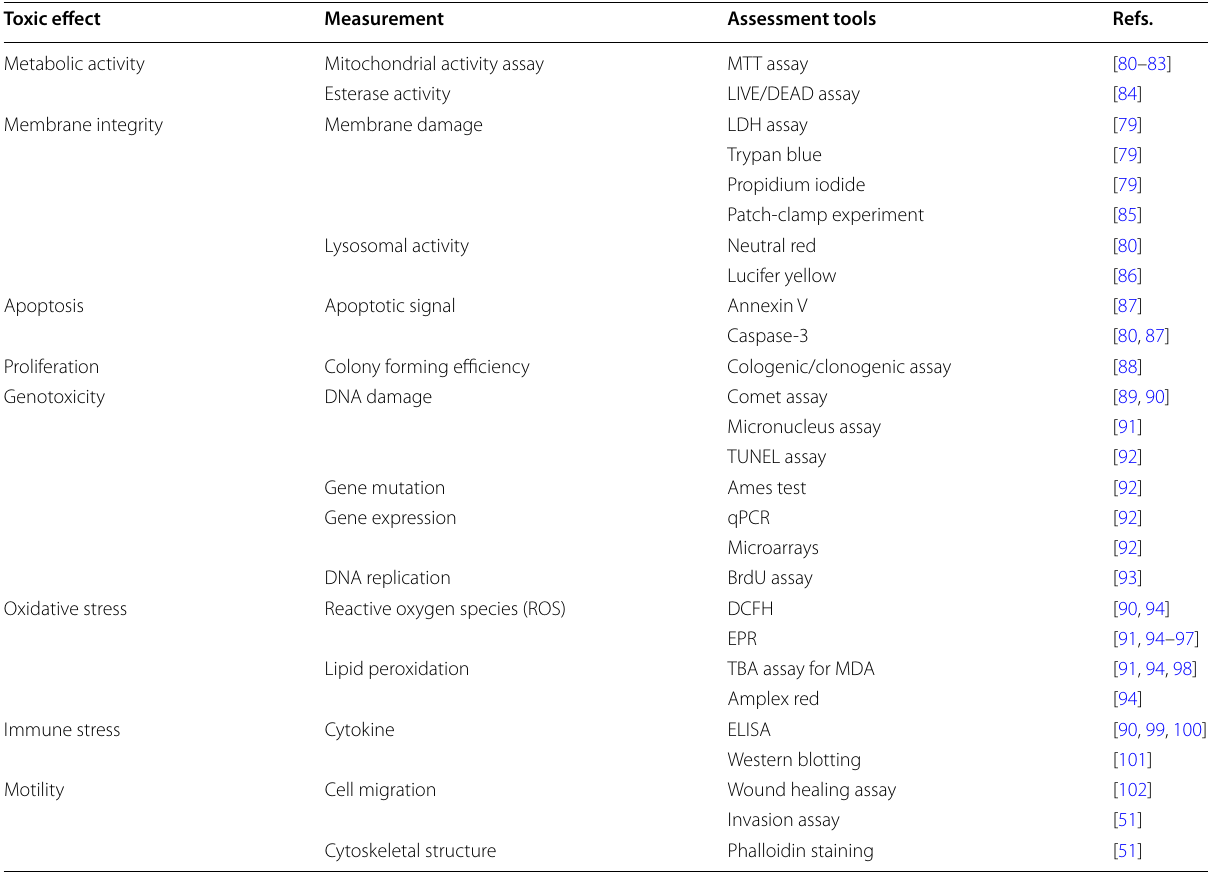
Table 1 Analytical methods for in vitro assessment of